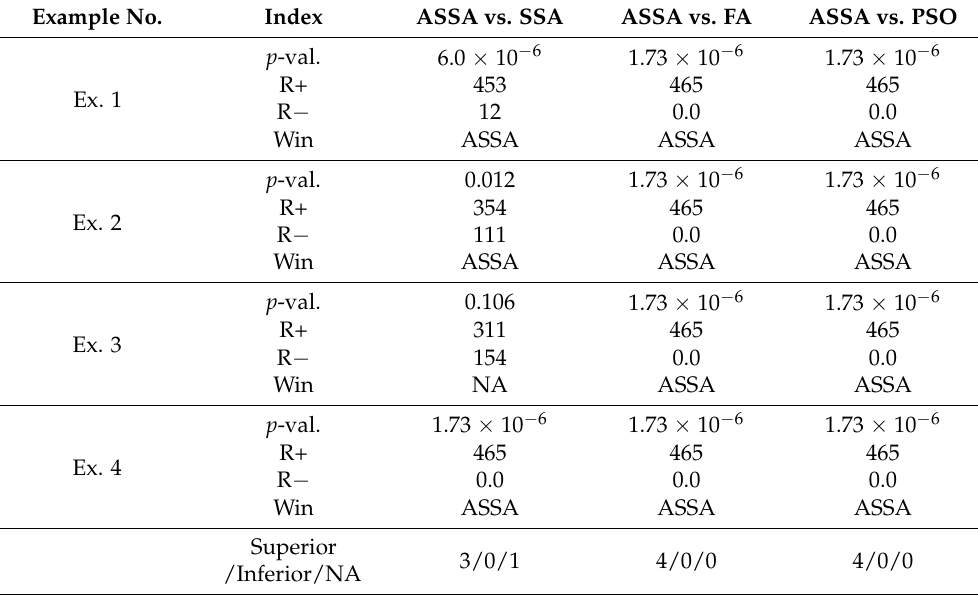
Table 20. Results of Wilcoxon’s rank sum test for design examples. Example